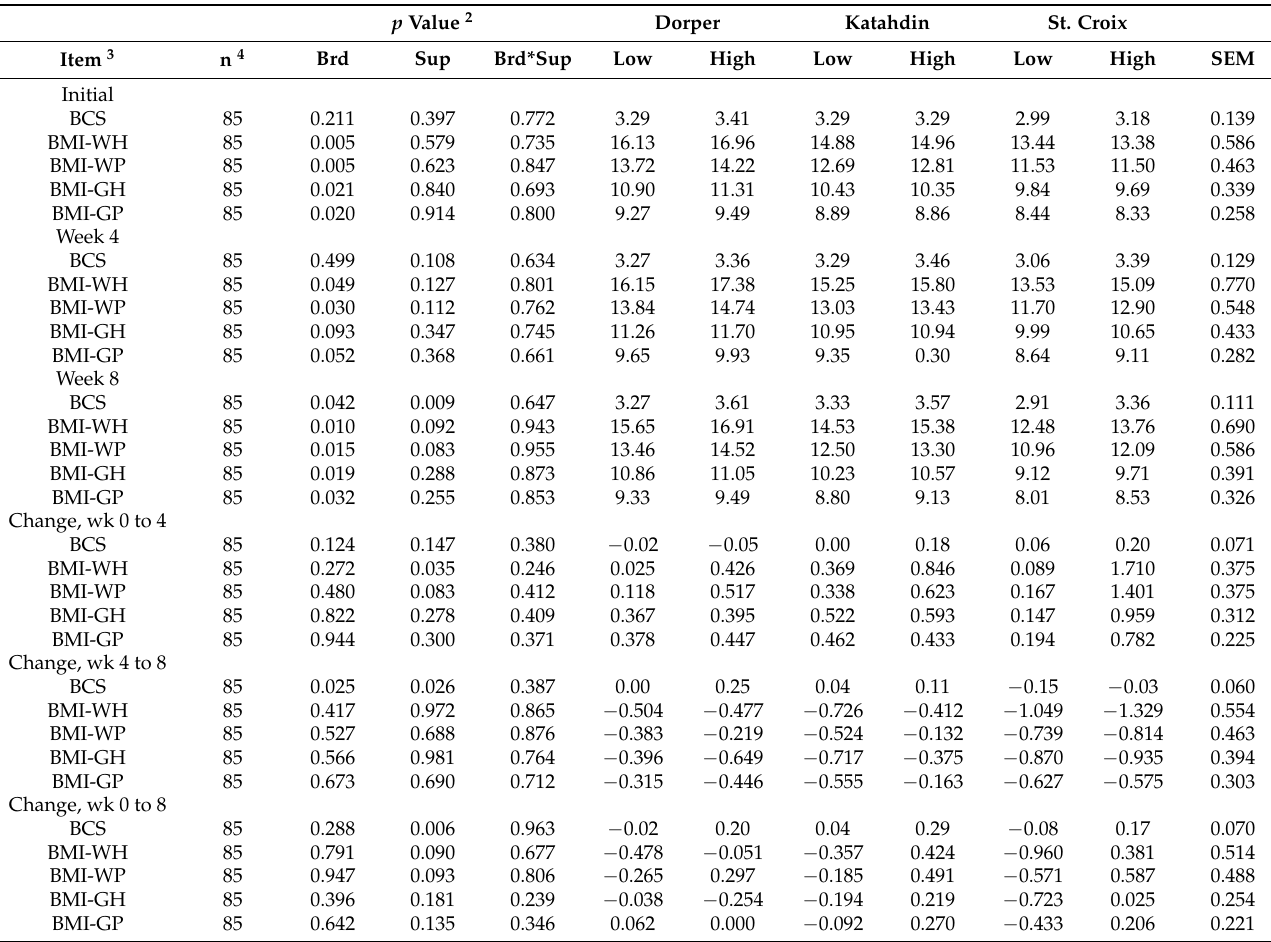
Table 7. Effects of breed and supplementation treatment on body condition score and body mass indexes of hair sheep 1